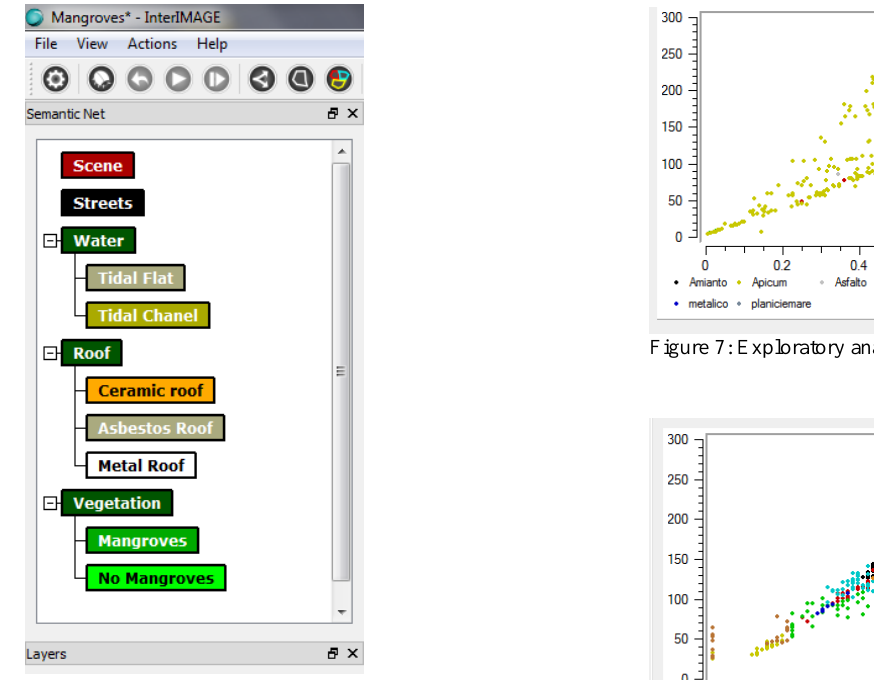
Figure 5: Semantic network elaborated at InterIMAGE.